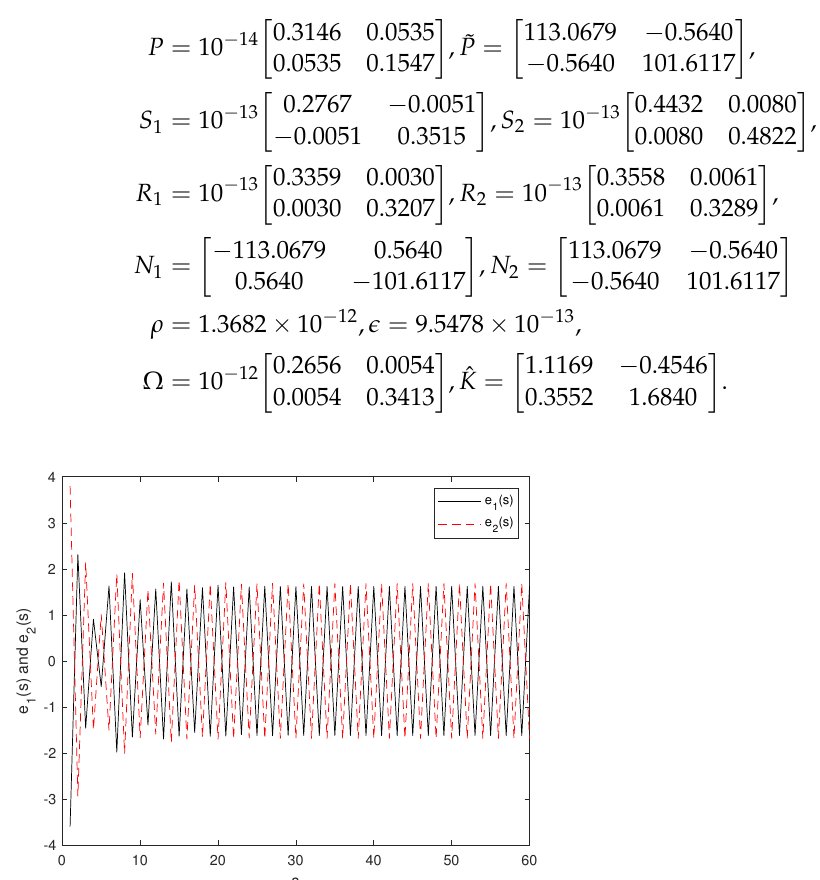
Figure 2. Trajectory curve of an error system e ( s ) without